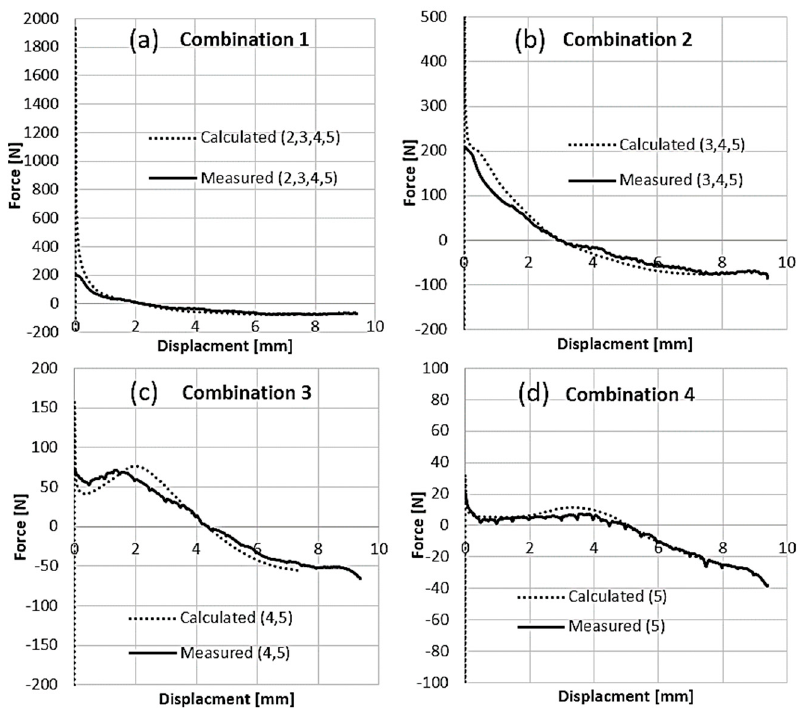
Figure 5. The comparison of experimentally measured (multi-static) and the numerically calculated magneto-static force obtained with different combinations of coil activation: ( a ) Combination 1, ( b ) Combination 2, ( c ) Combination 3, and ( d ) Combination 4.